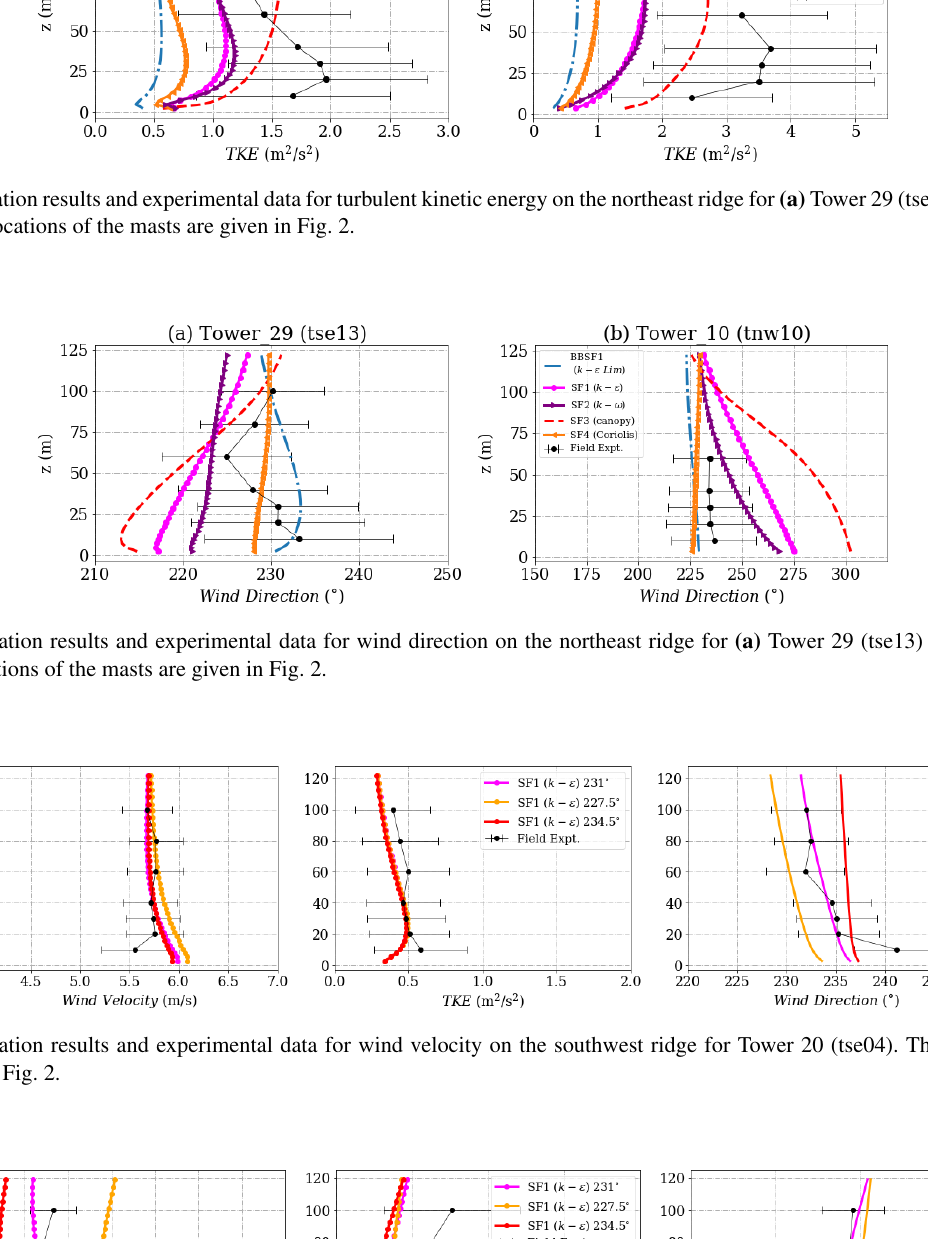
Wind Energ. Sci., 8, 85–108,